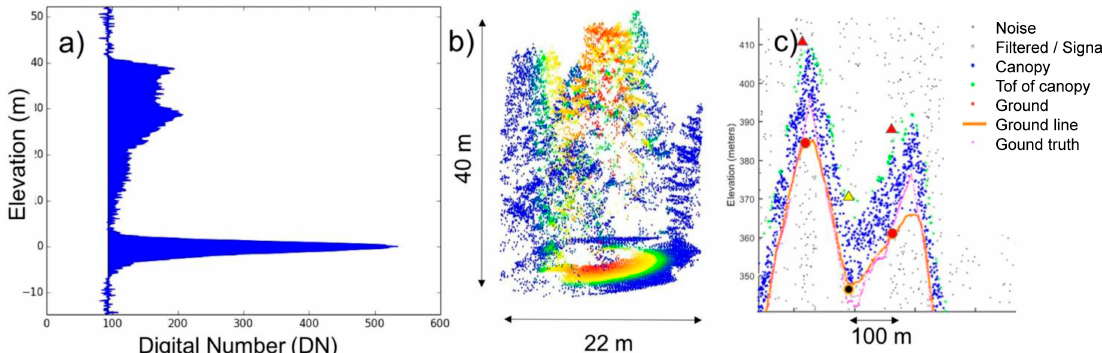
Figure 7. Simulated Global Ecosystem Dynamics Investigation GEDI waveforms ( a ) are vertical aggregations of point clouds ( b ) in GEDI sized footprints, which have been modeled to match expected pulse shape and spatial distribution of reflected energy for GEDI. ICESat-2 simulations ( c ) use degraded point clouds along transects with added background noise. Simulated photon returns are classified as noise, ground, or vegetation returns (taken from Duncanson et al. [132], License Nr: 4856241027296).